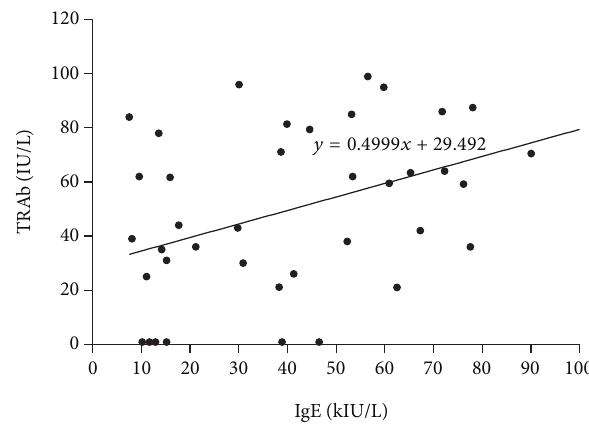
Figure 1: Correlation between TRAb and IgE in Graves’ disease patients. Positive correlation between TRAb and IgE in Graves’ disease patients and Pearson’s correlation coefficient, 𝑟 = 0.43 ( 𝑃 = 0.006 ), with regression line 𝑦 = 0.4999𝑥 + 29.492